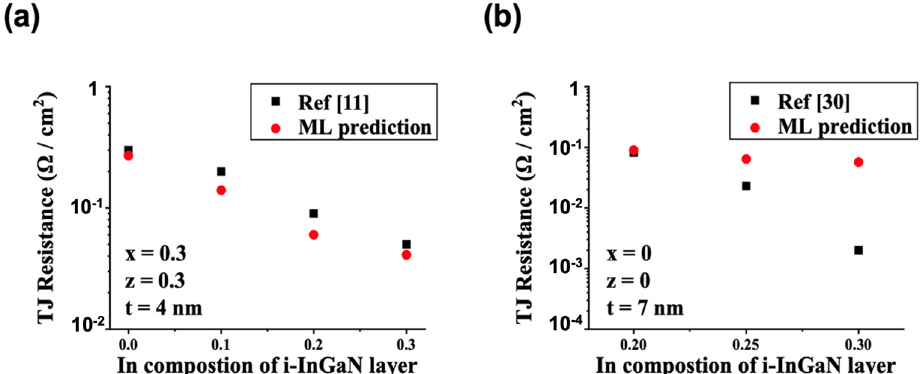
Figure 3. ( a ) p-Al 0.3 Ga 0.7 N/i-In y Ga 1-y N/n-Al 0.3 Ga 0.7 N TJ structures with the 4 nm interlayer [11], and ( b ) p-GaN/i-In y Ga 1-y N/n-GaN TJ structures with the 7 nm interlayer [30].